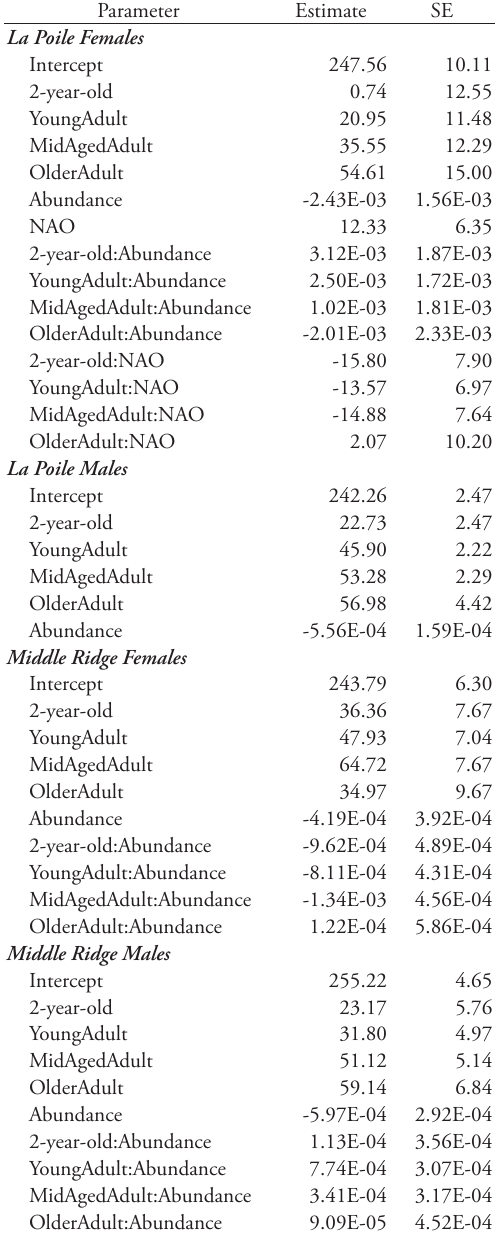
Table 2. Parameter estimates (± 1 SE) for the top models predicting total jawbone length for male and female caribou in the La Poile and Middle Ridge herds. The top models were selected by an info-theoretical